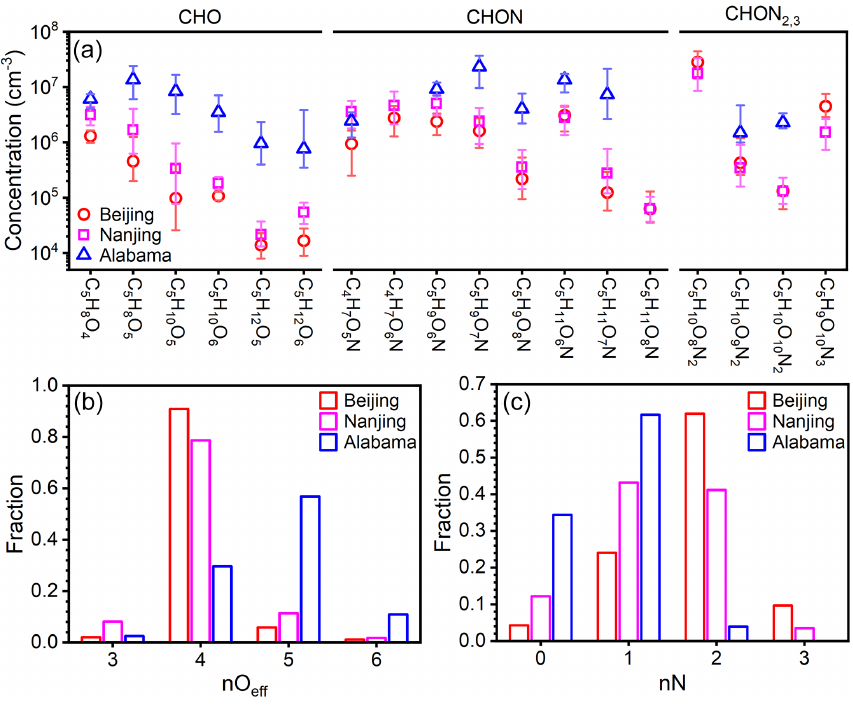
Figure 6. (a) Concentration comparison of specific fingerprint IP OOM molecules between our study and previously reported ones (Krech- mer et al., 2015; Massoli et al., 2018; Liu et al., 2021). The markers are median concentration values, and the upper and lower bounds of the error bars denote 25th and 75th percentiles, respectively. The distribution of the (b) effective oxygen number, nO eff , and (c) nitrogen number, nN, of IP OOMs is plotted in panel (a)